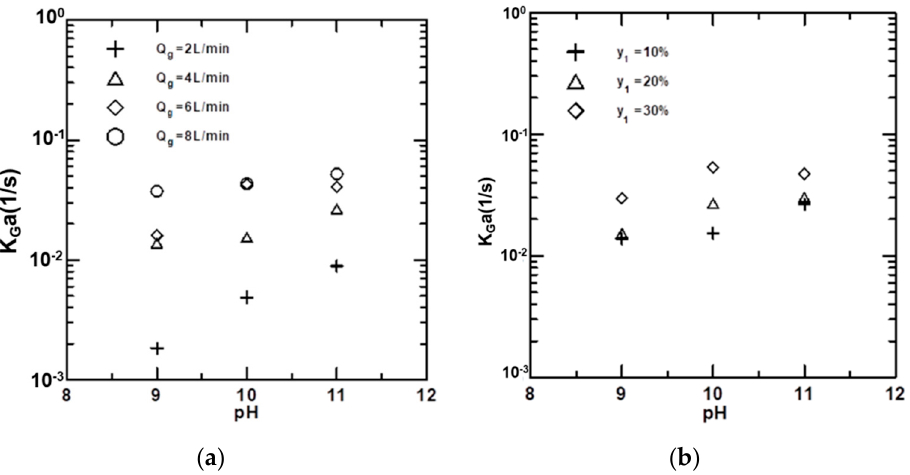
Figure 9. Effects of variables on the K G a at different conditions. ( a ) Effects of pH at different gas-flow rates; ( b ) Effects of pH at different gas concentrations.